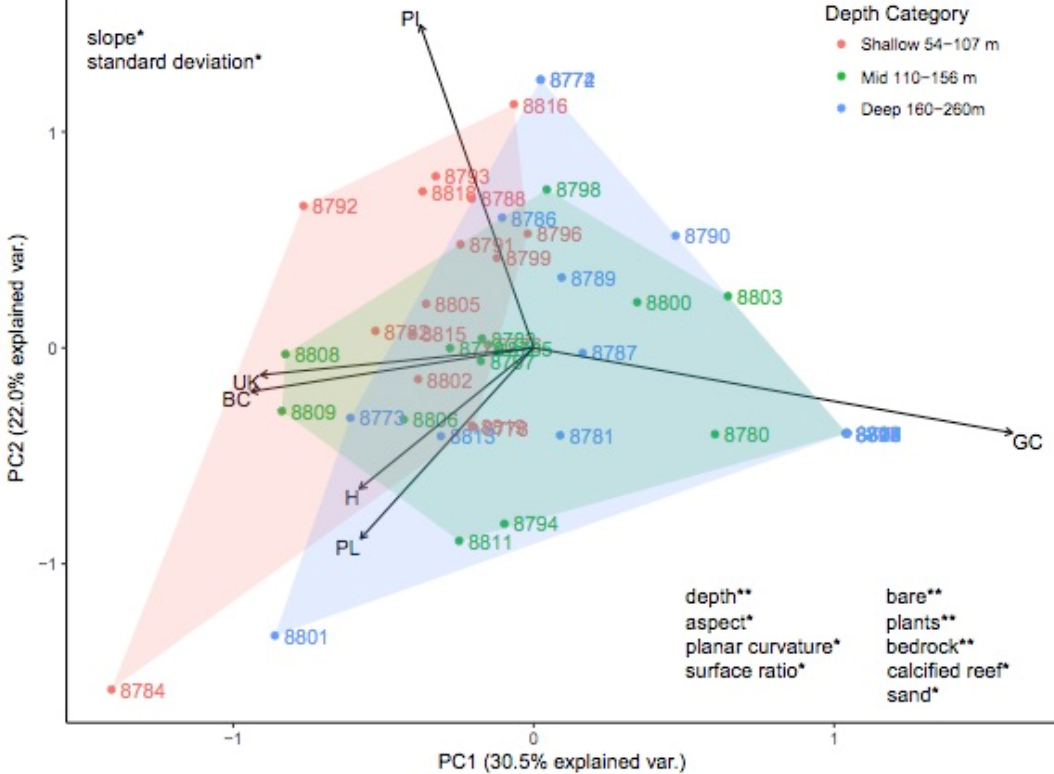
Figure 9. Principal Component Analysis show trophic community differences of fishes between sites sampled on shelf-break reefs. The first two principal components explain 52.5% of the variation in trophic diversity between sites. Sites are grouped by depth category and each has a unique number. Vectors depicting the principal feeding strategies (H = herbivores, PI = piscivores, PL = planktivores, BC = benthic carnivores, GC = general carnivores, UK = unknown) show some of the key differences between sites. Environmental variables found to significantly contribute to the community differences along PC1 and PC2 are summarized next to the corresponding axis (** p < 0.01 and * p < 0.05).